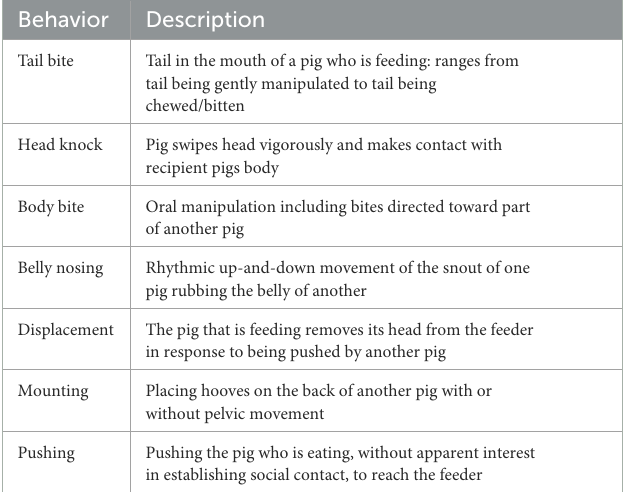
TABLE 1 Ethogram for all occurrence behavior observations at pen level. Behavior Description